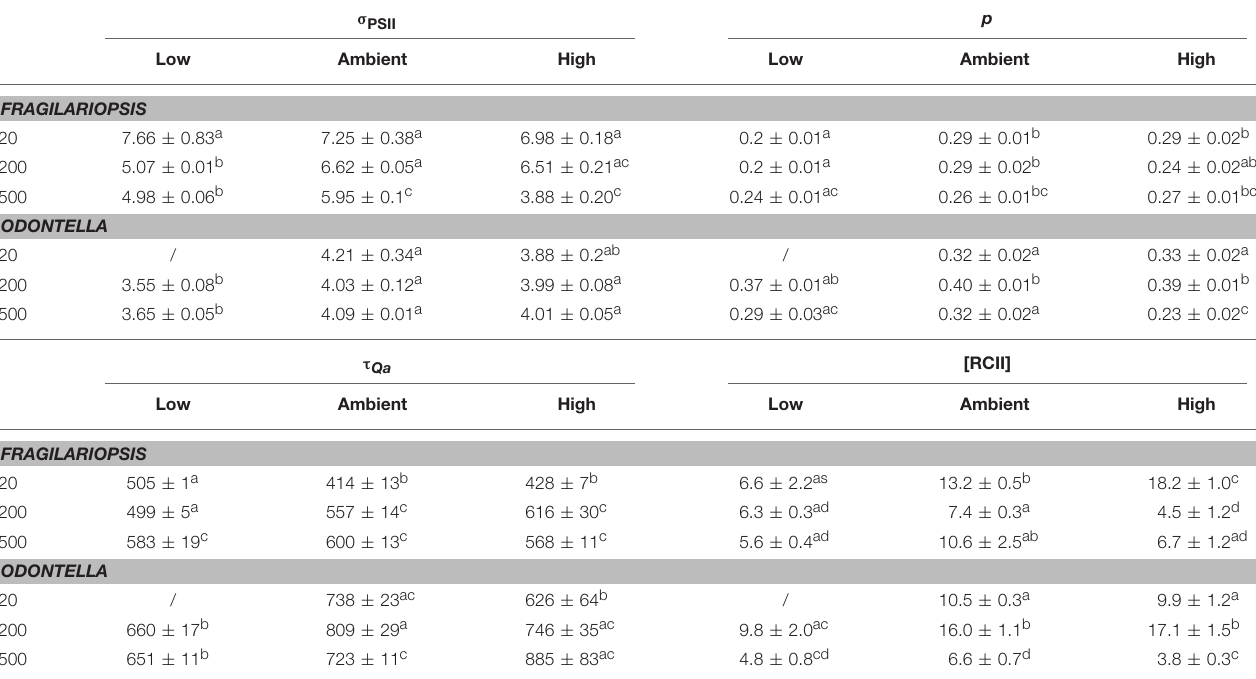
TABLE 4 | Functional absorption cross section ( σ PSII , nm − 2 quanta − 1 ), the connectivity factor (p, dimensionless) of adjacent PSII light-harvesting pigment matrices, time constant for electron transport at the acceptor side of PSII ( τ Qa , µ s) and the concentration of functional PSII reaction centers ([RCII], nmol m − 3 ) were determined for Fragilariopsis and Odontella acclimated to different light (LL = 20, ML = 200, HL = 500 µ mol photons m − 2 s − 1 ) and pCO 2 (low = 180, ambient = 380 and high = 1000 µ atm)